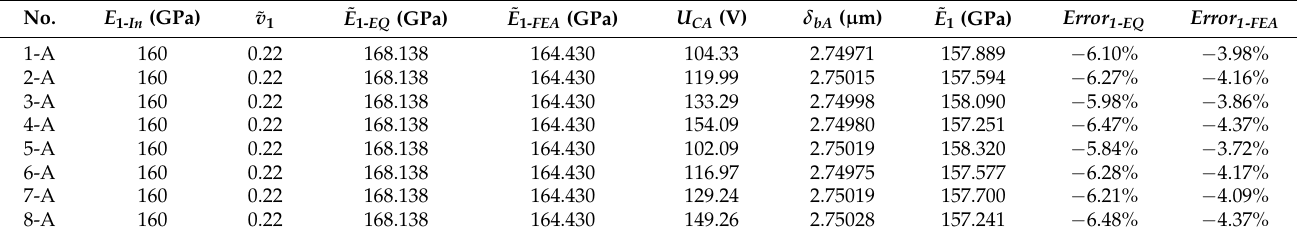
Figure 5. Simulation results of test structure A. Table 3. Finite element simulation results of test structure A.